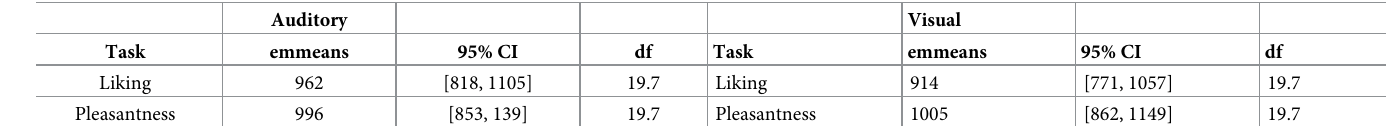
Table 4. Estimated marginal means for Model 4i.